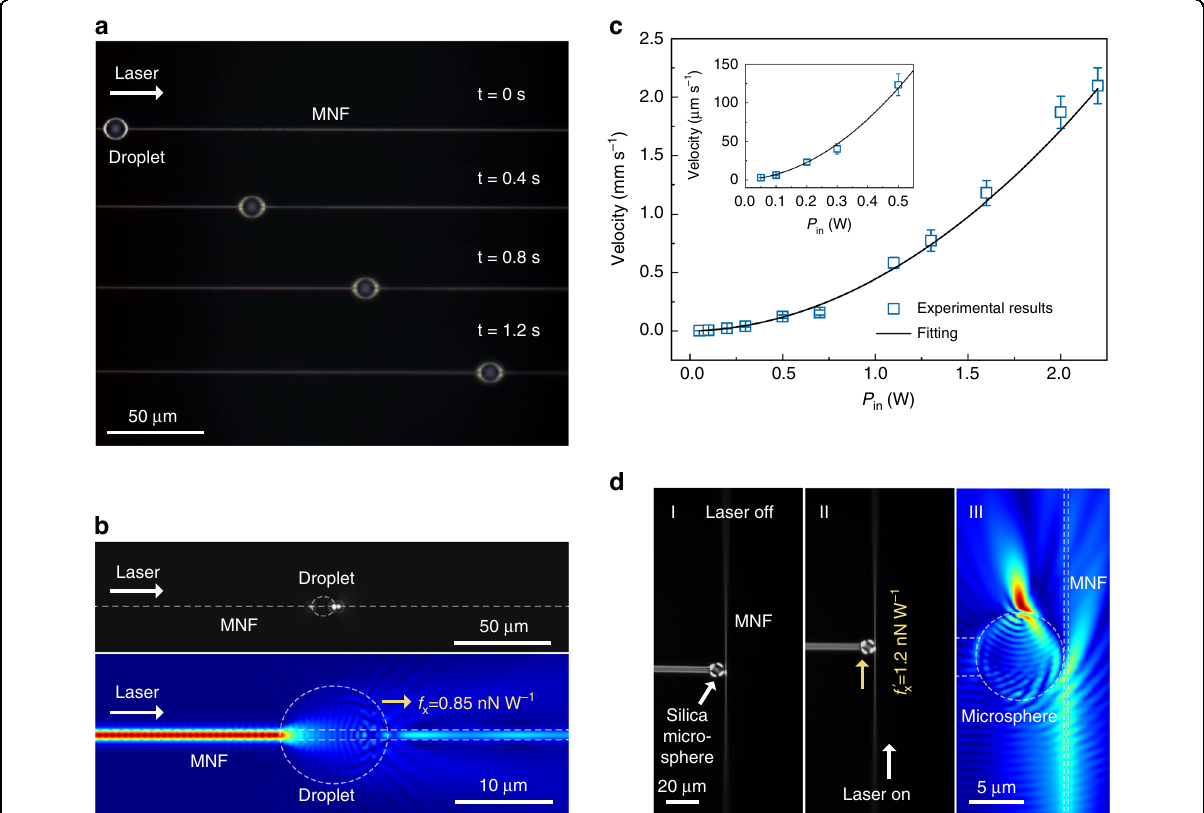
Fig. 3 High-power CW optomechanical manipulation using MNFs waveguiding a 1552-nm-wavelength light. a Time-sequential optical microscope images of driving an oil droplet (11 μ m × 10 μ m ellipsoid) along a 1- μ m-diameter MNF at 0.4-s intervals. A 0.7-W-power light is waveguided along the MNF from left to right. b Optical microscope image (upper) and fi eld intensity calculation (bottom) of the fundamental waveguiding mode in a 1- μ m-diameter MNF scattered by an oil droplet wrapped around. c Measured (blue squares) and fi tted (black line) power- dependent velocity of the oil droplet driven by the waveguiding light in the MNF. Inset, a close-up of the droplet velocity with waveguided power below 0.5 W. d Optical microscope image (I, II) and fi eld intensity calculation (III) of optomechanical manipulation of an 8- μ m-diameter silica microsphere via an evanescent fi eld of a 410-nm-diameter MNF. The gap between the microsphere and the MNF is ~0.1 μ m. The waveguided power is 4 W. The white dash lines in b and d indicate the geometric pro fi les of the MNF, the droplet and the silica microsphere,